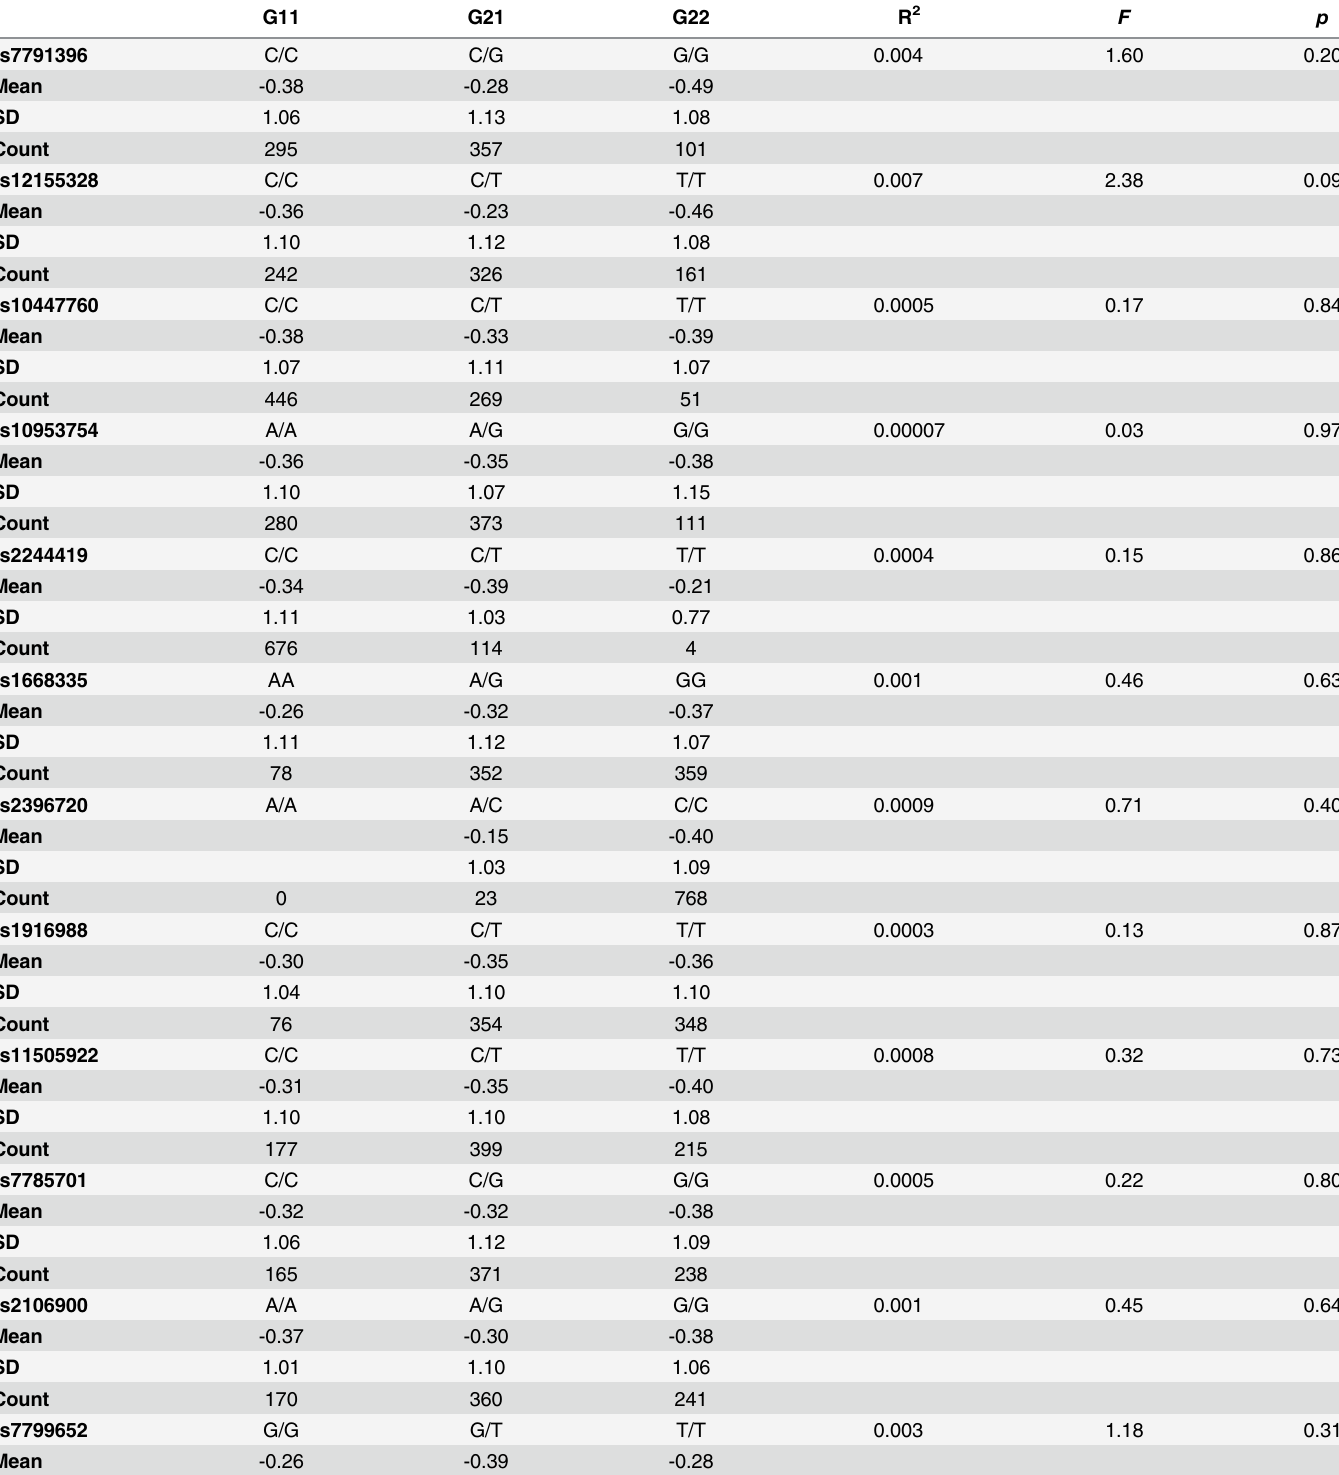
Table 1. Means and standard deviations ( SD ) of language composite scores for tag SNP genotypes within FOXP2 and effect sizes ( R 2 ) of geno- types on language in the combined Iowa